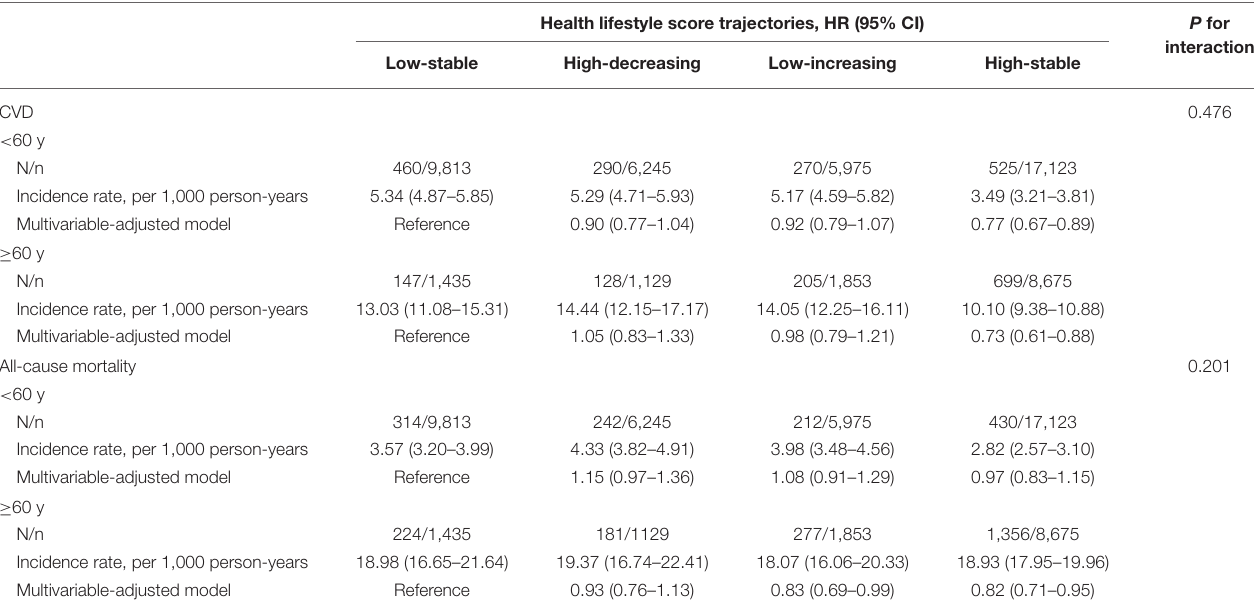
TABLE 4 | Stratified analysis of CVD and all-cause mortality according to age